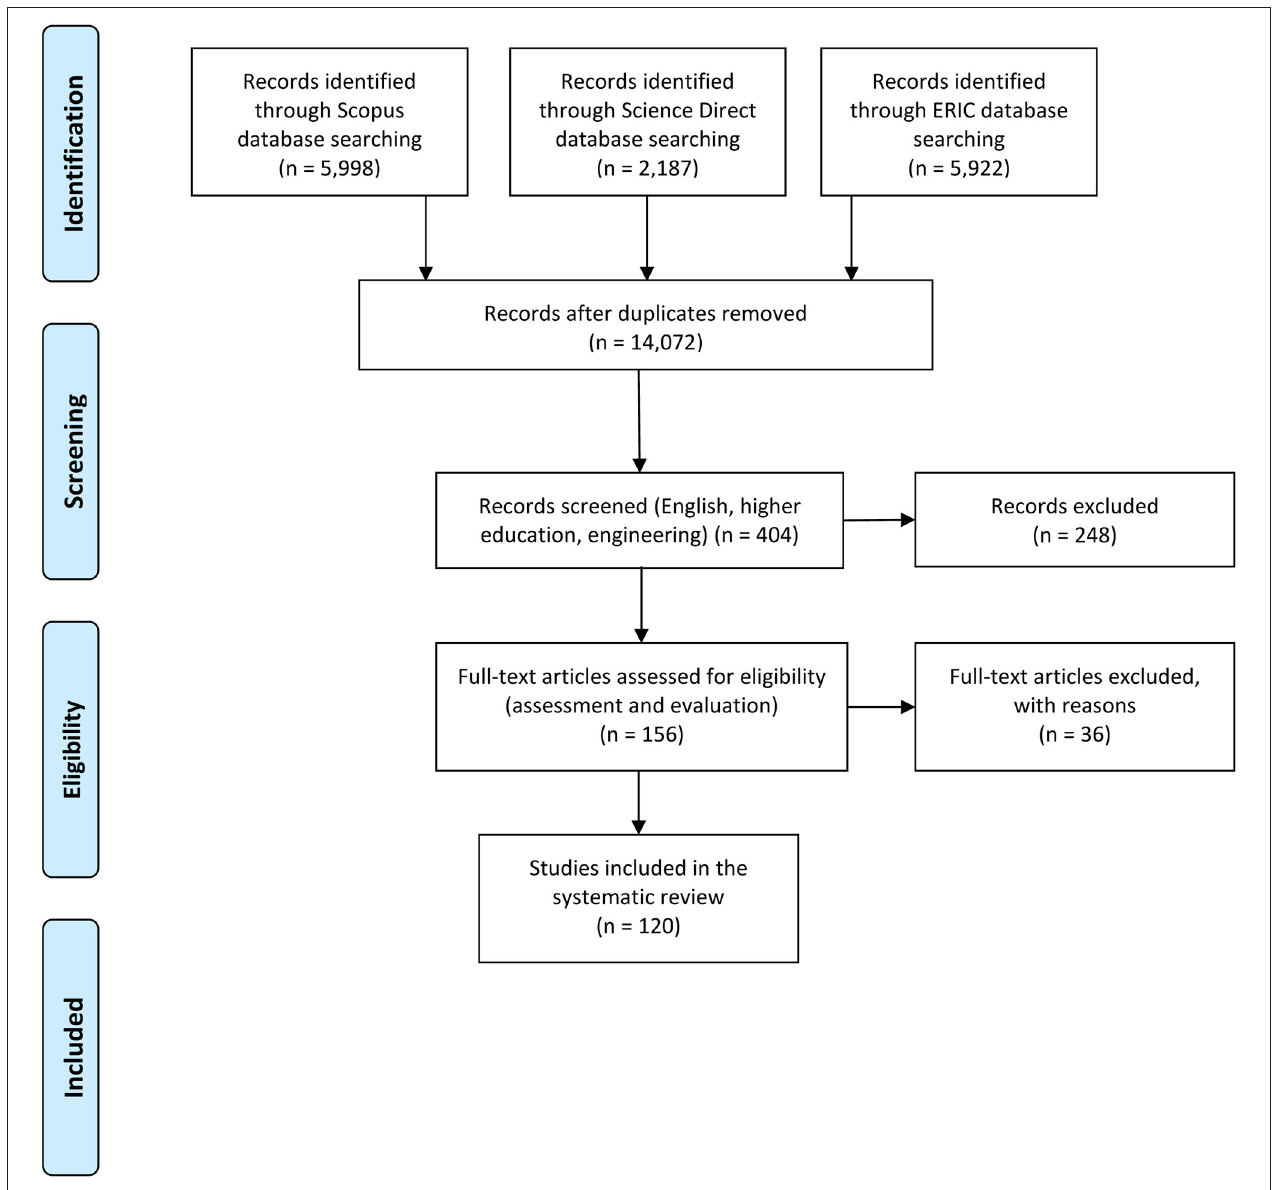
FIGURE 2 | PRISMA flow diagram for the search developed during the review process (Moher et al.,